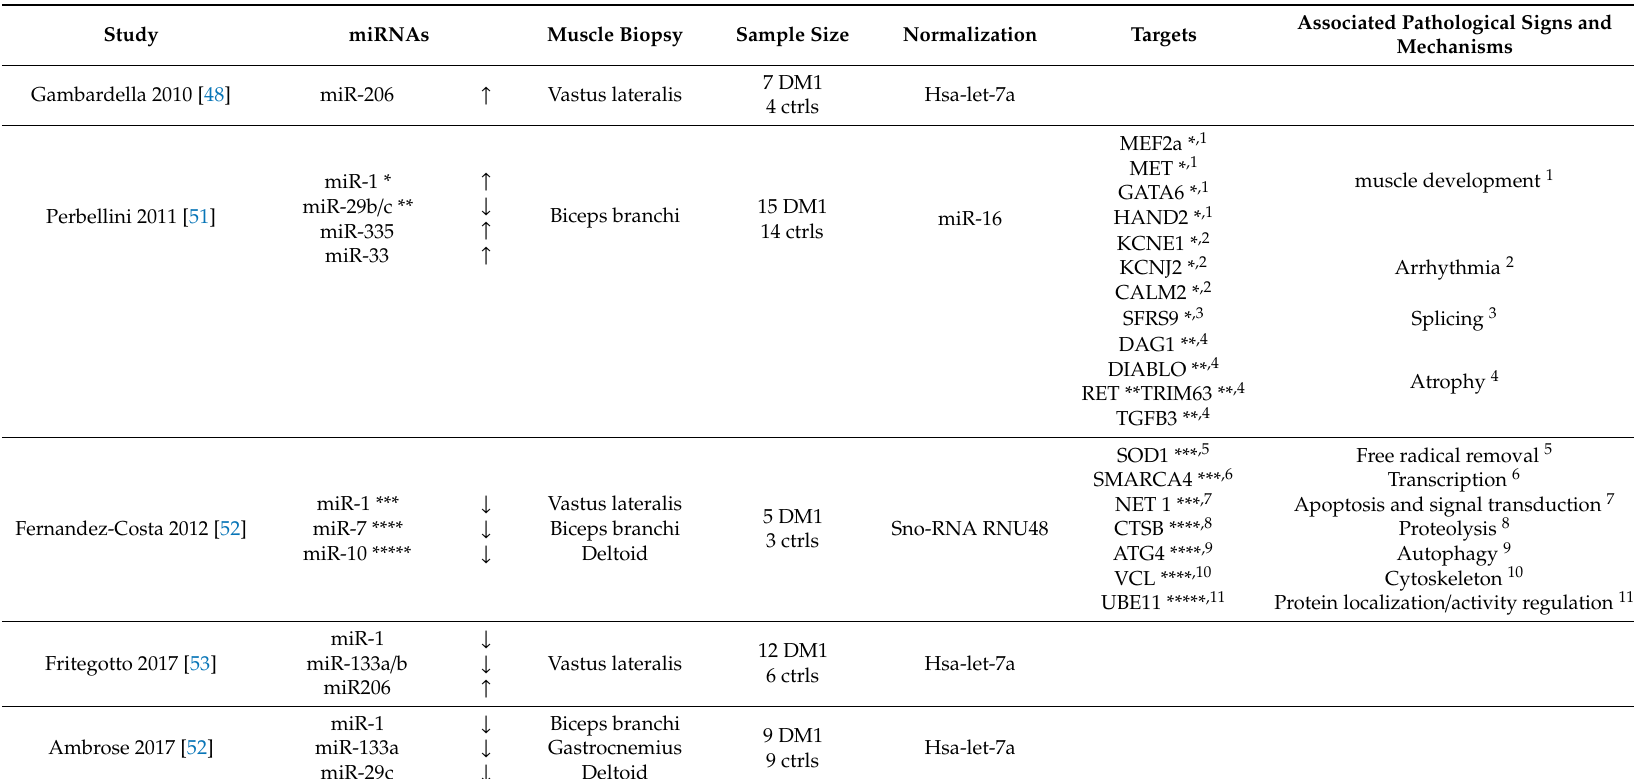
Table 1. Overview of the di ff erentially expressed miRNAs analyzed in muscle